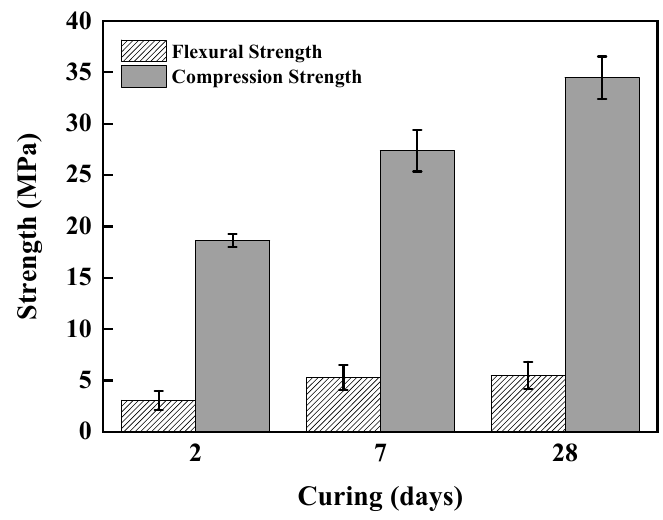
Figure 7. Flexural and compressive strength vs . curing days.